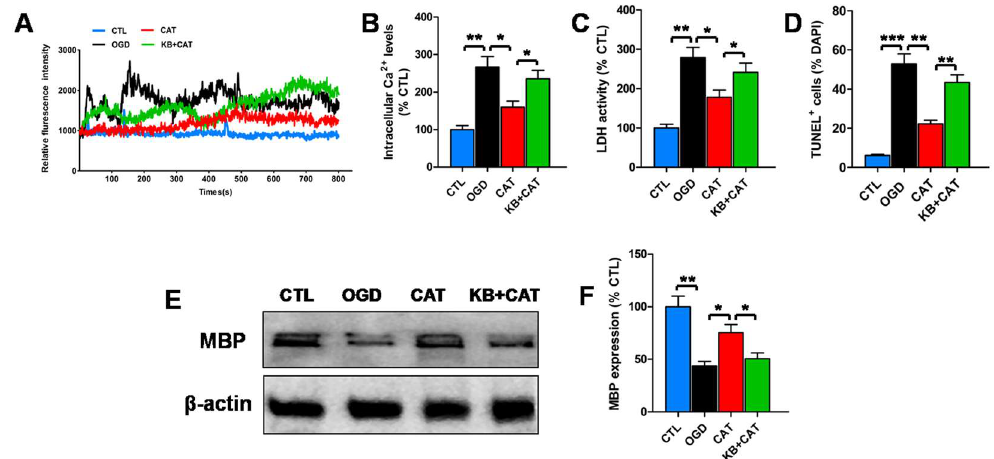
Figure 5. Effects of catalpol on intracellular Ca 2+ levels, cytosolic LDH activity, cell survival, and maturation of PreOLs under OGD and 2-[2-[4-(4-nitrobenzyloxy)phenyl]ethyl]isothiourea (KB-R7943) treatment. ( A ) Representative Ca 2+ response traces under resting condition in the CTL, OGD, CAT, and KB-R7943+catalpol-treated group (KB+CAT) groups. ( B ) Quantification of intracellular Ca 2+ levels at the resting condition measured by Fluo-3 staining in the CTL, OGD, CAT, and KB+CAT groups. ( C ) Quantification of LDH activity in the CTL, OGD, CAT, and KB+CAT groups. ( D ) Quantification of TUNEL-positive cells in the CTL, OGD, CAT, and KB+CAT groups. ( E ) Western blot probing for MBP in the CTL, OGD, CAT, and KB+CAT groups. β -actin was used as a loading control. The blot shown is representative of six independent experiments. ( F ) Quantification of MBP protein expression levels from the Western blot analyses. Data are shown as means ± SEM ( n = 6 in each group). * p < 0.05; ** p < 0.01; *** p < 0.001.